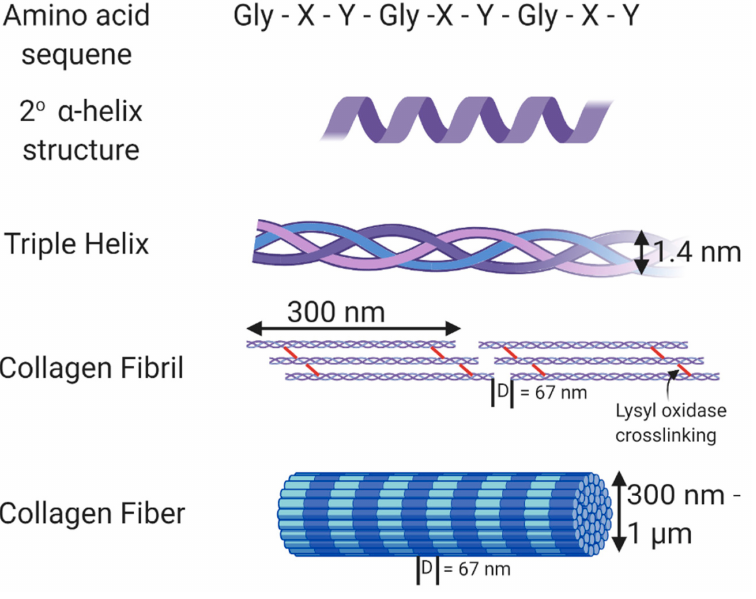
Figure 2. Structure of collagen [56].